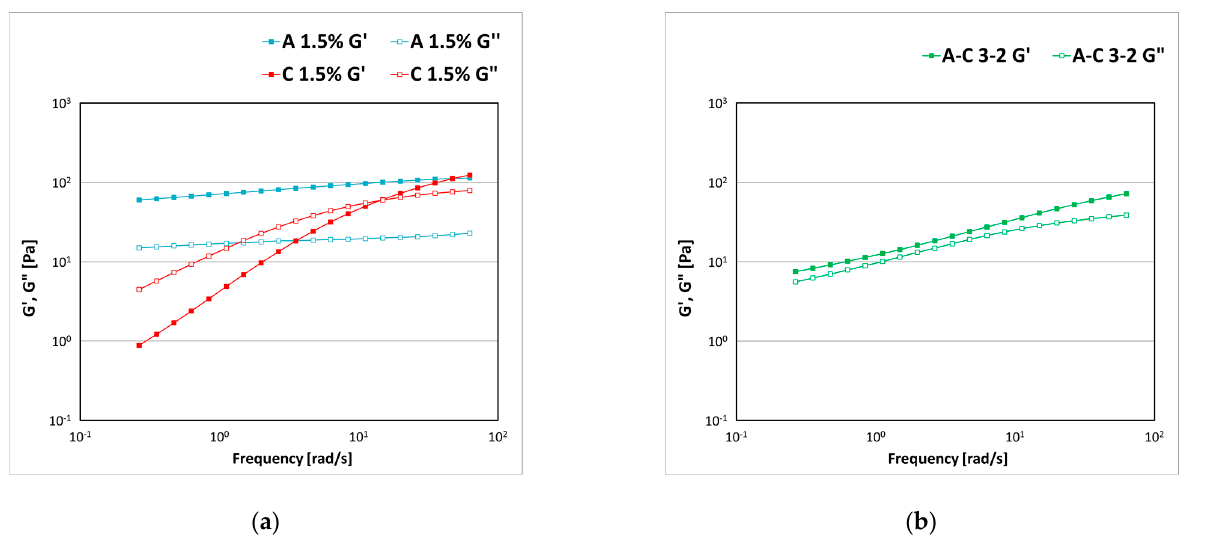
Figure 6. Storage (G ′ ) and loss (G ″ ) moduli trends as a function of the frequency for the samples prepared with A and C ( a ) and the A–C association (3:2) ( b ) at the same total polymer amount (1.5% w/w). A was characterized by the lowest values of tan δ and more elastic behavior. The as- ure 7).